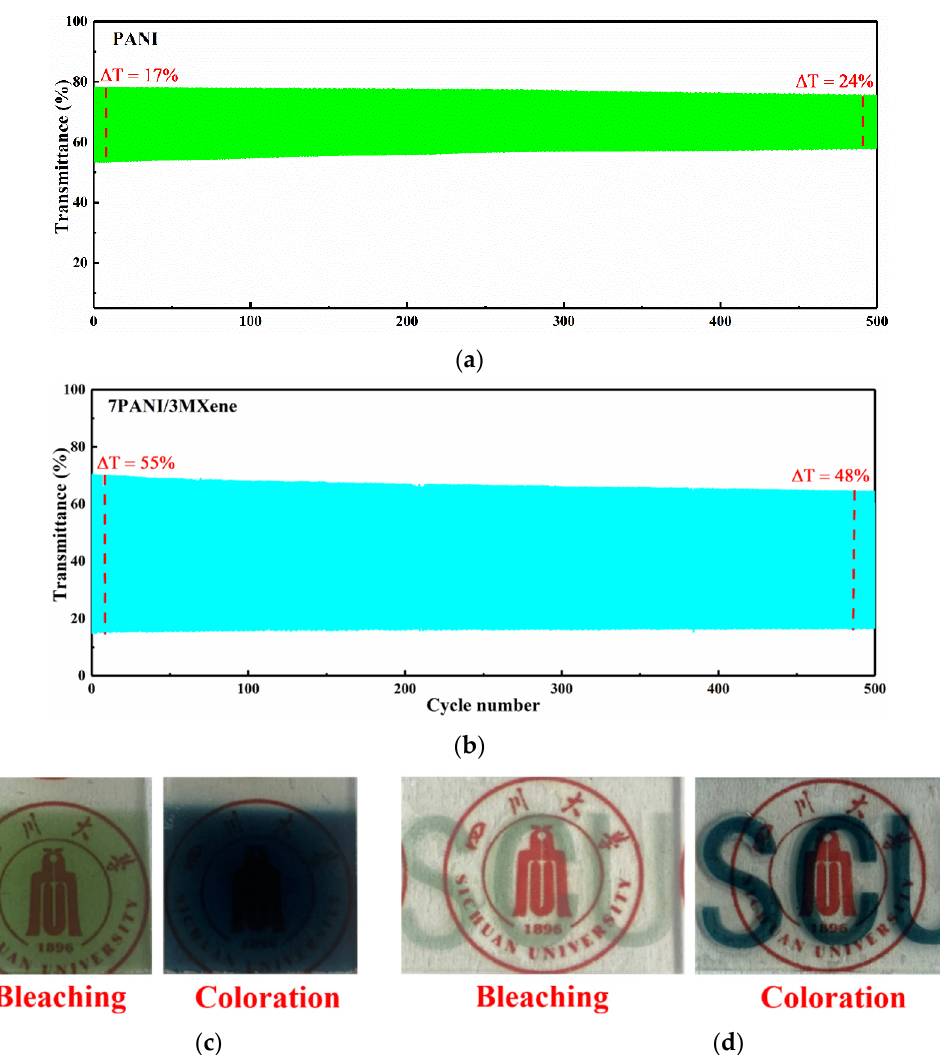
Figure 7. ( a , b ) Cycling stability testing of PANI and PANI/MXene films for 500 cycles at 700 nm; ( c ) photograph of PANI/MXene nanocomposite film at − 0.4V (bleaching state) and +0.8V (coloration state); ( d ) photograph of the patterning electrochromic film based on PANI/MXene.